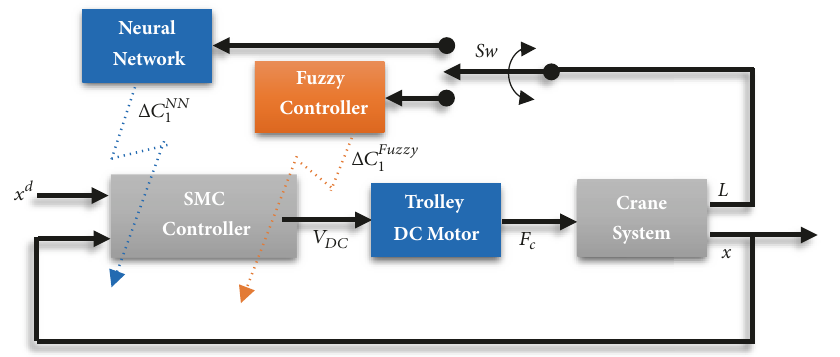
Figure 3: Closed-loop system block diagram with proposed intelligent SMC tuning algorithms.